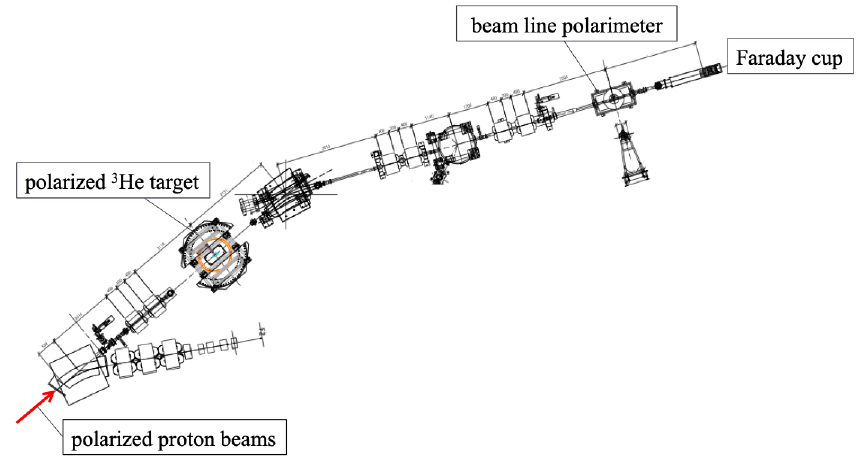
Figure 1: Schematic view of the experimental setup for p – 3 He scattering at the ENN course,